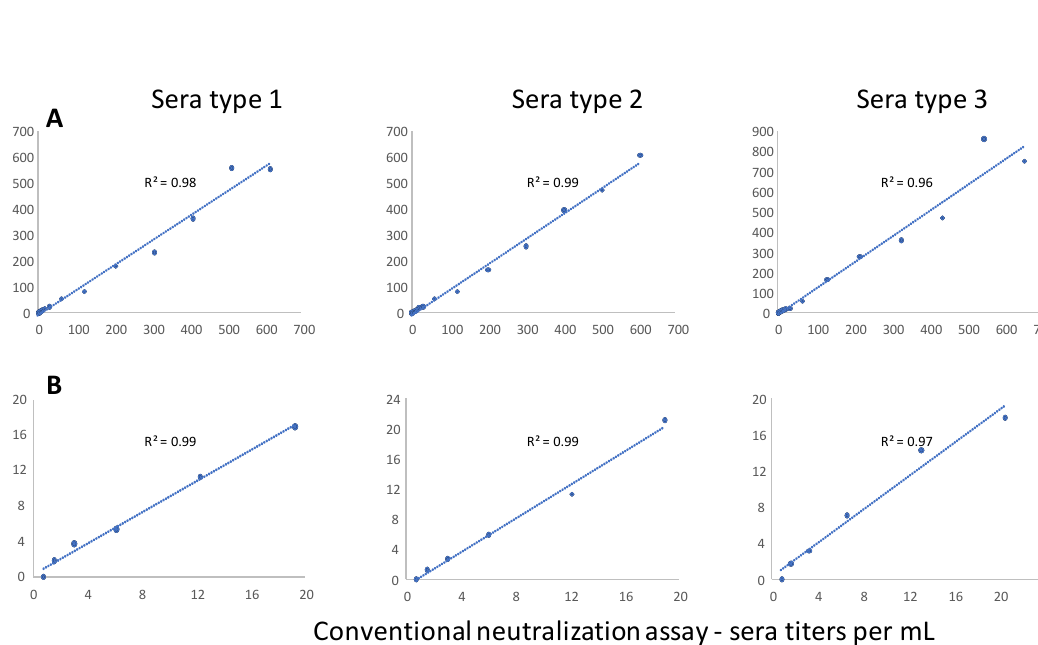
Table 4. Impact of HEp-2C cell number variability on anti-poliovirus sera titers generated by MPBN assay.